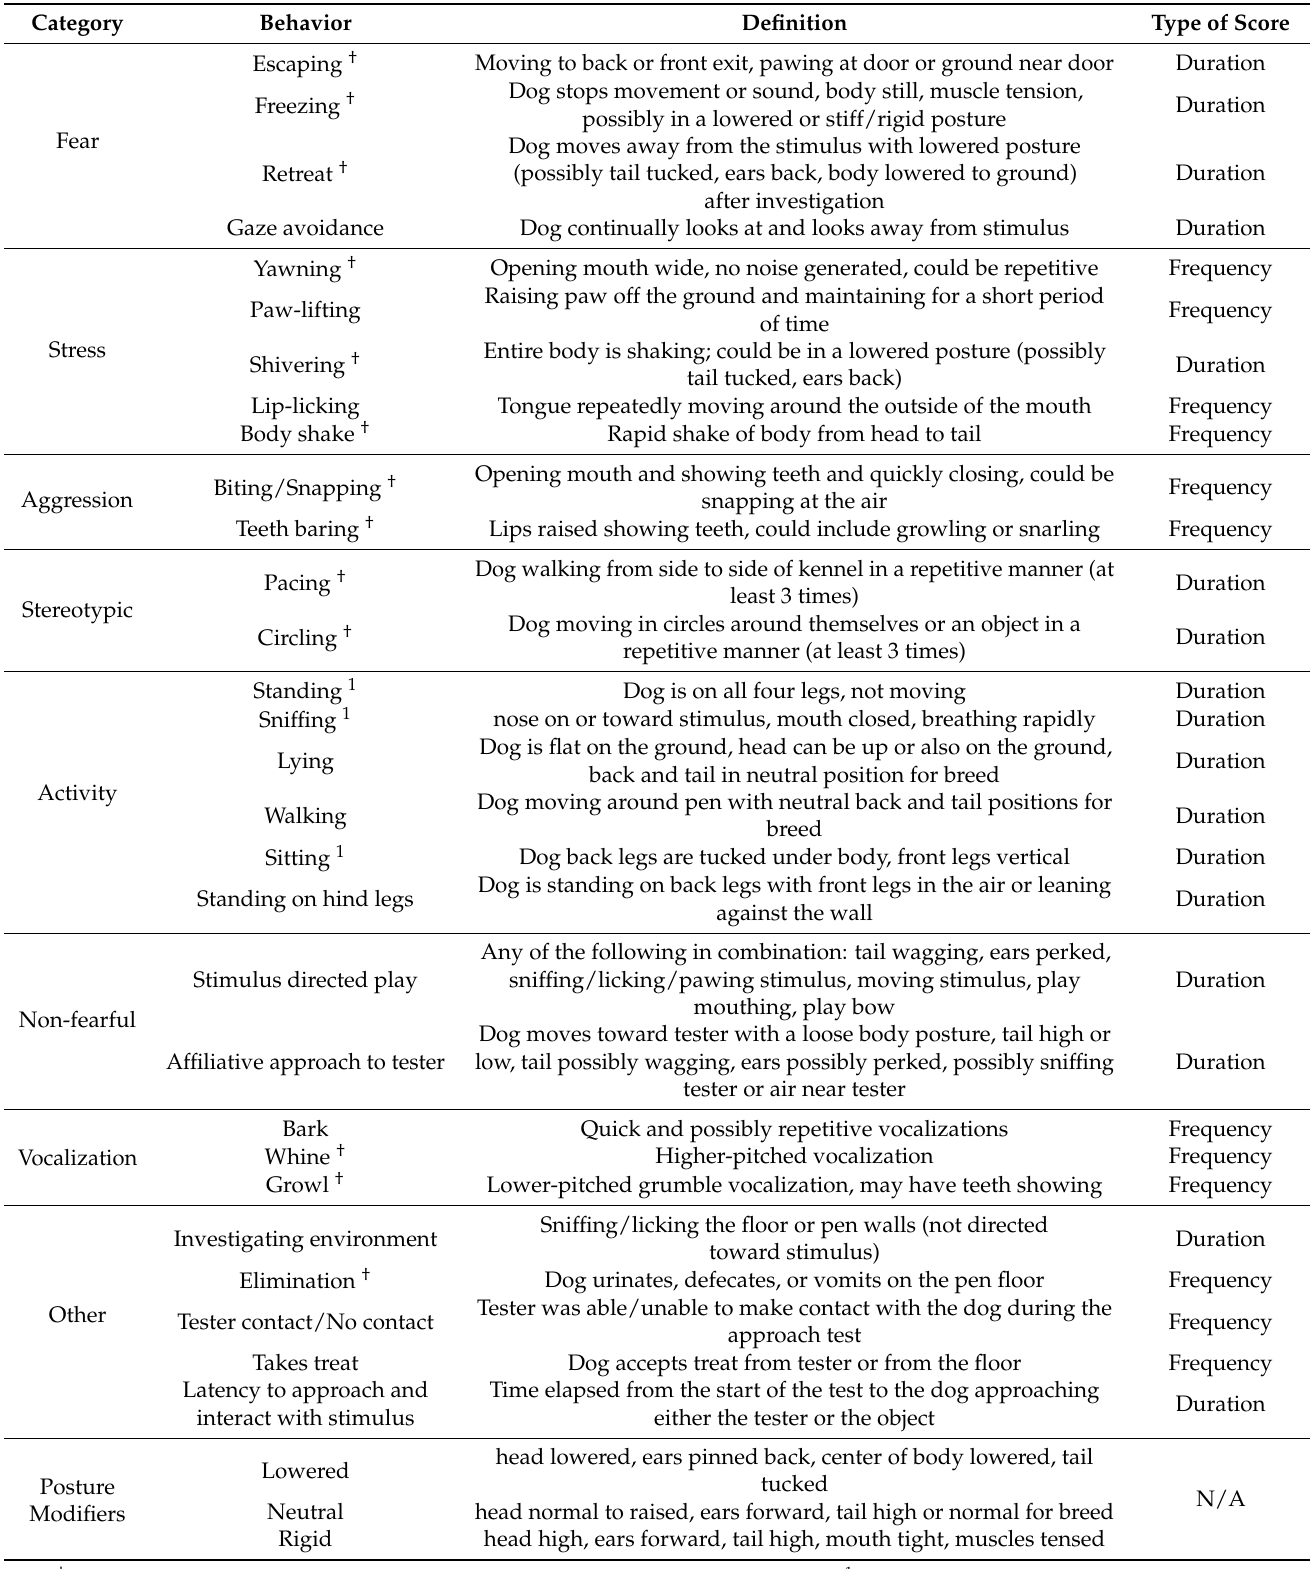
Table 2. Ethogram used to analyze the behavior of dogs. Behaviors were scored in terms of duration or frequency of